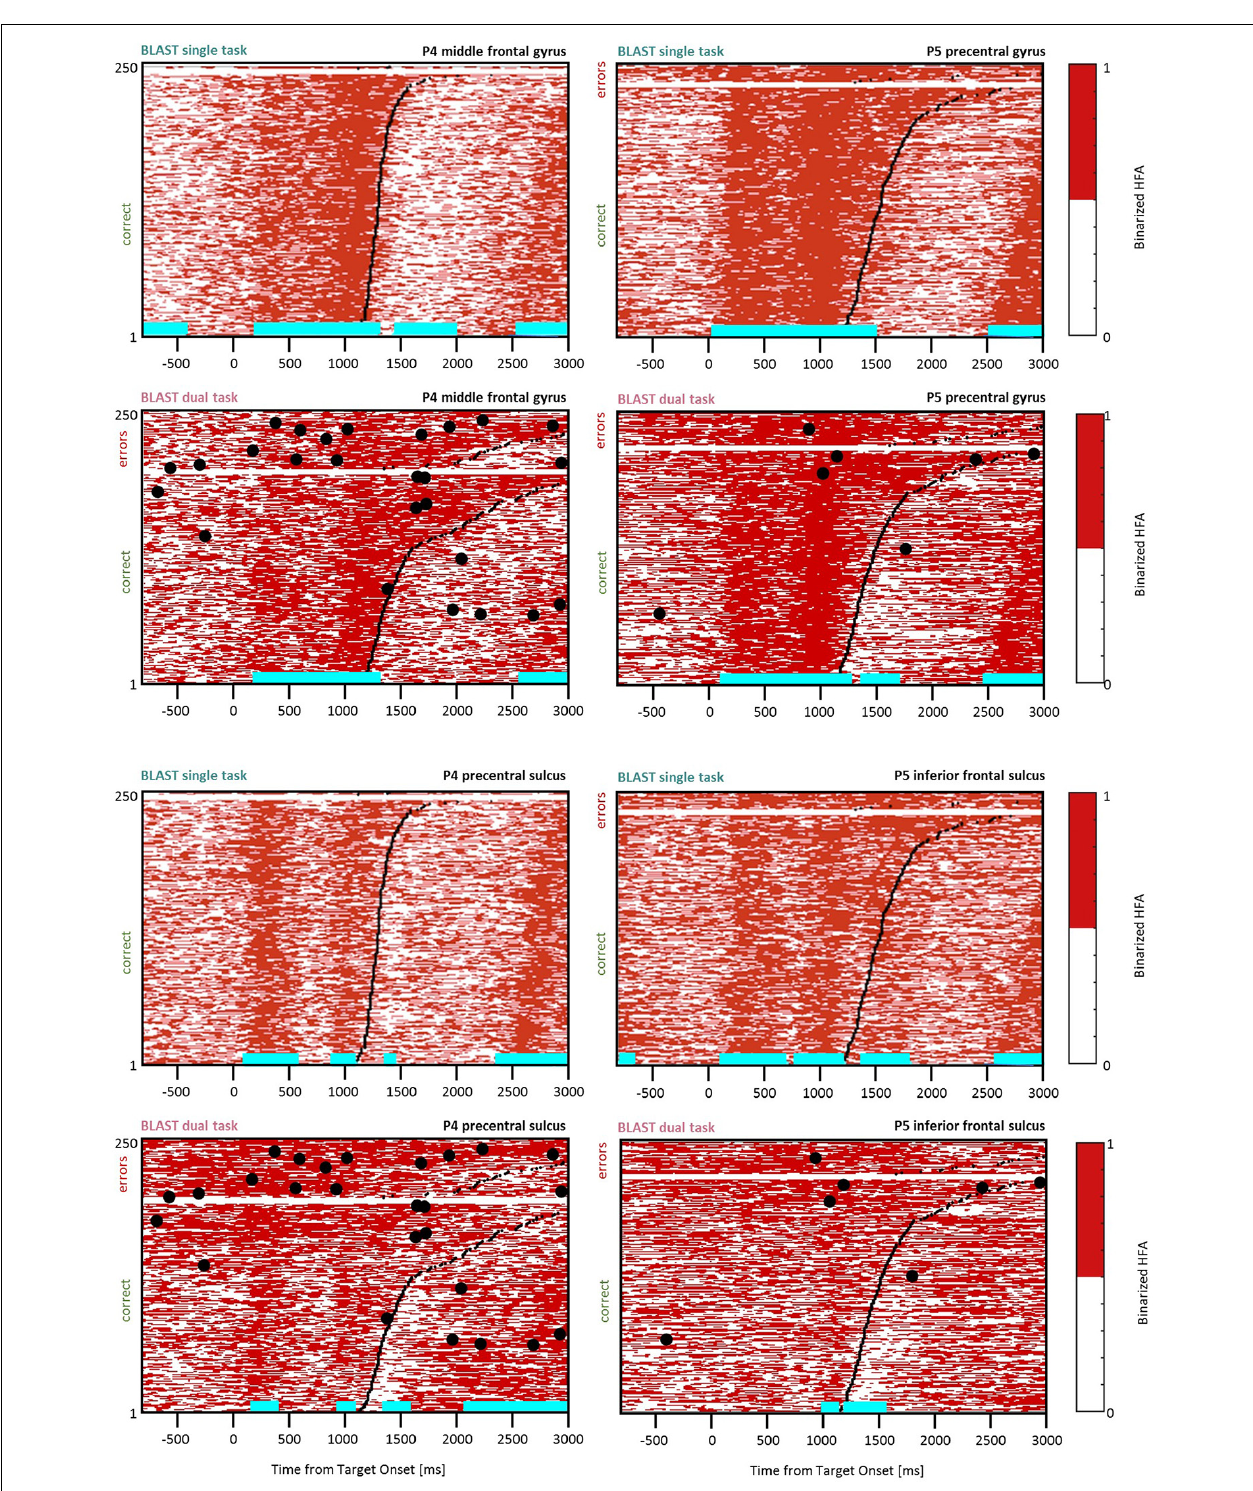
FIGURE 10 | Slowing down of the response selection process. Comparison of BLAST-related activity in the ST and DT conditions for four sites (two of them with no significant VFT interference-top four panels). For each site, BLAST-related neural activity is represented as a binarized matrix for the ST and DT conditions. Horizontal lines (cyan) indicate samples with a significant increase or decrease relative to the [ − 200:0 ms] pre-Target baseline. From left to right and top to bottom, iEEG sites and [Patients id] are: G’8 [P4]; S’12 [P5]; R’4 [P4]; K’10 [P5].